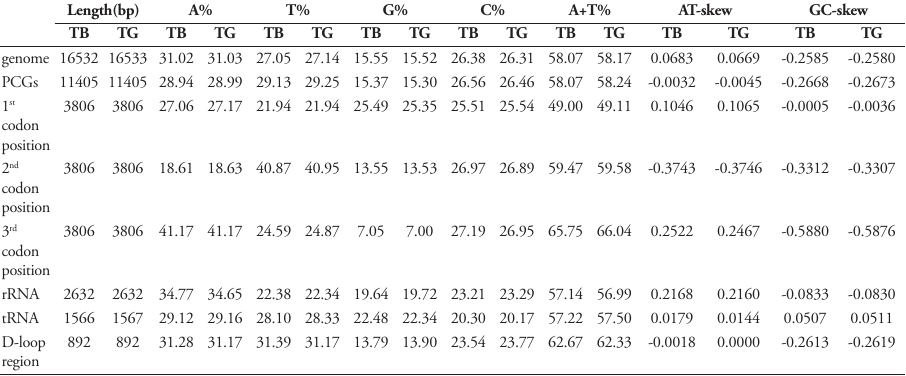
Table 2. Nucleotide composition of the mitochondrial genomes of T. brachyrhabdion (TB) and T . gracilis